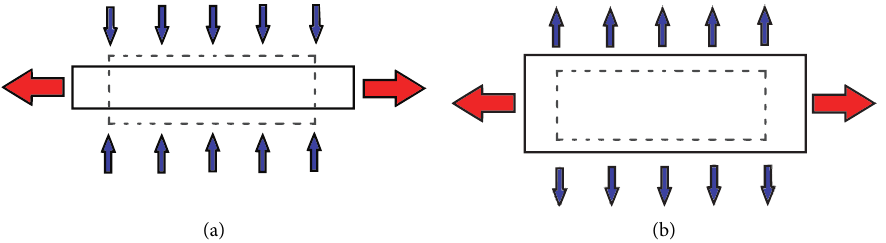
Figure 1: The original material depicted in dashed lines is subjected to the longitudinal strain represented by the red arrows. (a) Nonauxetic behavior where the original material contracts in the direction of the blue arrows, while (b) an auxetic behavior where the original material expands in the direction of the blue arrows.